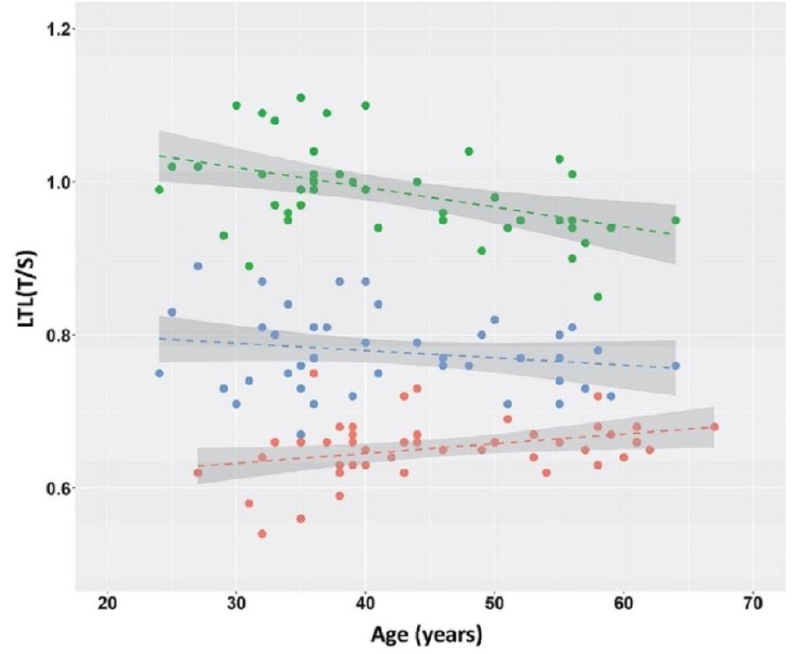
Figure 2. LTL values as a function of age at blood sampling. LTL measures expressed as a relative telomere length T/S ratio are presented for control subjects (green) and for patients in the pre-HD stage (blue) and the following corresponding HD stage (red). Linear regression lines are shown.